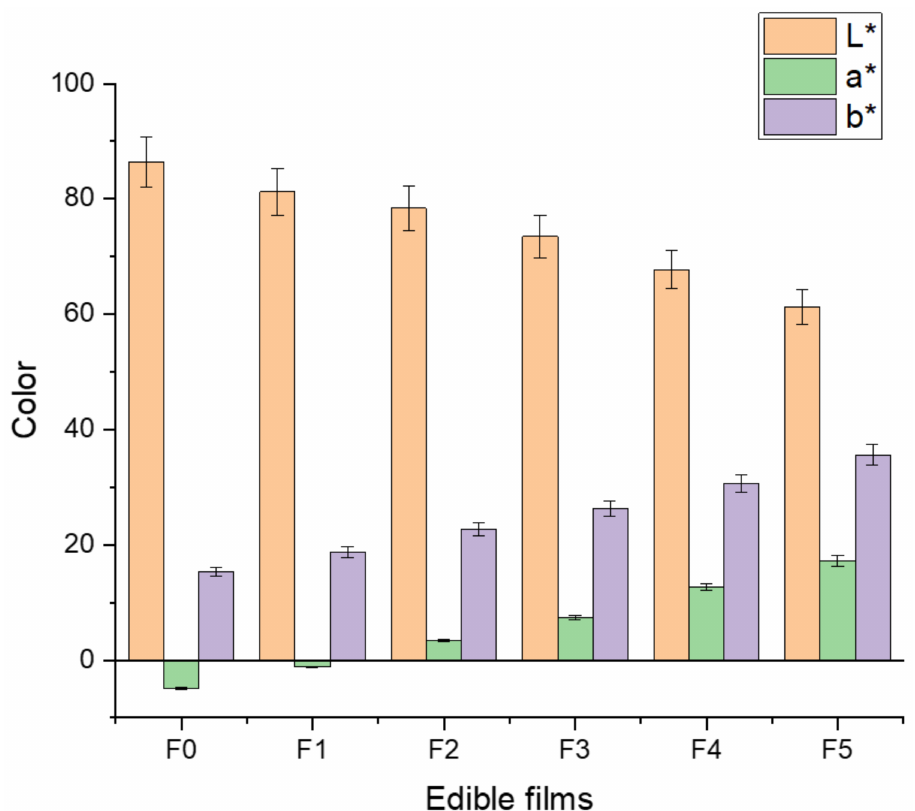
Figure 4. Effect of pomegranate peel extract on color (L*, a*, and b*) of chitosan-based edible films. F0 = control (chitosan), F1 = 0.02 g/mL PGP, F2 = 0.4 g/mL PGP, F3 = 0.6 g/mL PGP, F4 = 0.8 g/mL PGP, and F5 = 0.10 g/mL